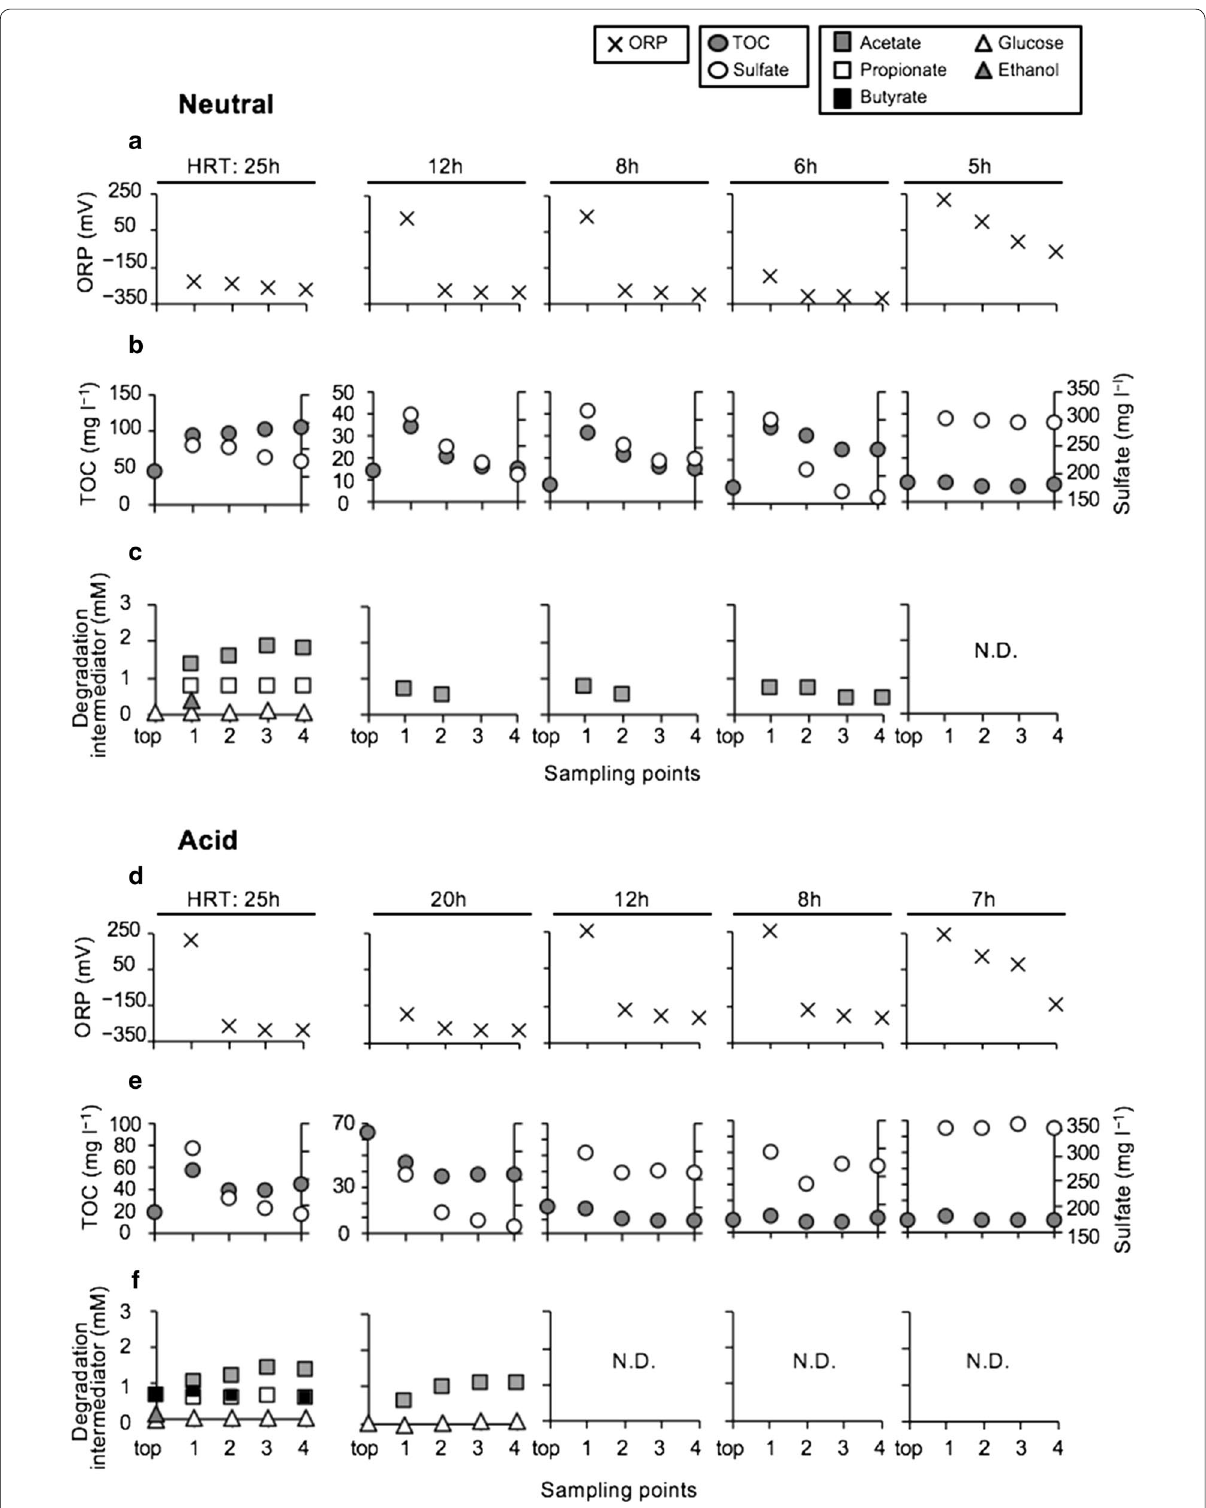
Fig. 2 Effects of HRT and pH on oxidation–reduction potential (ORP) ( a , d ), total organic carbon (TOC)/sulfate concentrations ( b , e ), and low- molecular-weight organic substrate concentrations ( c , f ) at each depth of the bioreactor under the neutral ( a – c ) and acid ( d – f ) conditions. Symbols ORP, saltires ; TOC, gray circles ; sulfate, open circles ; acetate, gray squares ; propionate, open squares ; butyrate, closed squares ; glucose, open triangles ; ethanol, gray